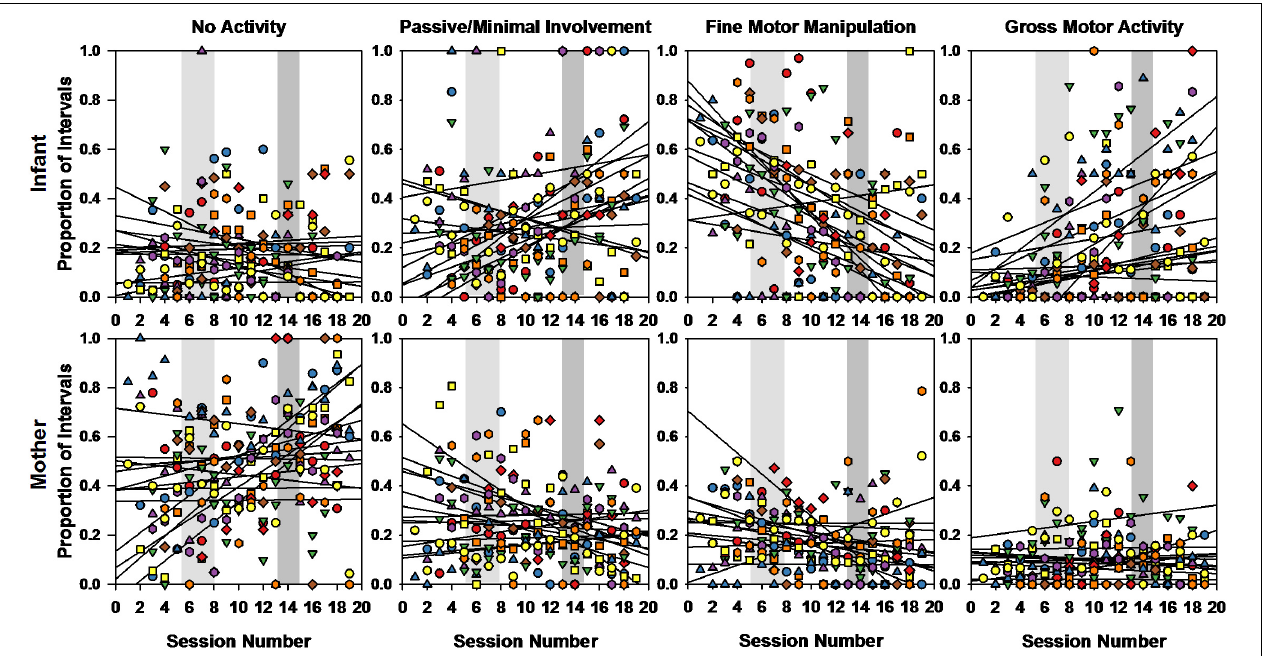
FIGURE 5 | Pearson correlations and corresponding regression lines showing the overall developmental trends for all 13 dyads (infants top, mothers bottom) for the proportion of intervals spent engaging in each type of interactive behavior (left to right: no activity, passive/minimal involvement, fine motor manipulation, and gross motor activity) while sitting. Regression lines for each participant fit the proportion of intervals of a given interactive behavior from 5 sessions before crawling onset, up to 5 sessions after walking onset. Light gray and darker gray shaded areas span the range of session numbers during which different infants learned to crawl and walk,